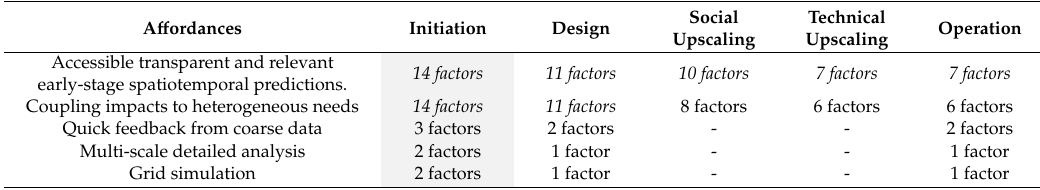
Table 11. Impact of a ff ordances by energy community lifecycle phase. Shaded cells indicate highest value in row, italic text indicates highest value in column. Social Technical Operation A ff ordances Initiation Design Upscaling Upscaling Accessible transparent and relevant 14 factors early-stage spatiotemporal predictions. Coupling impacts to heterogeneous